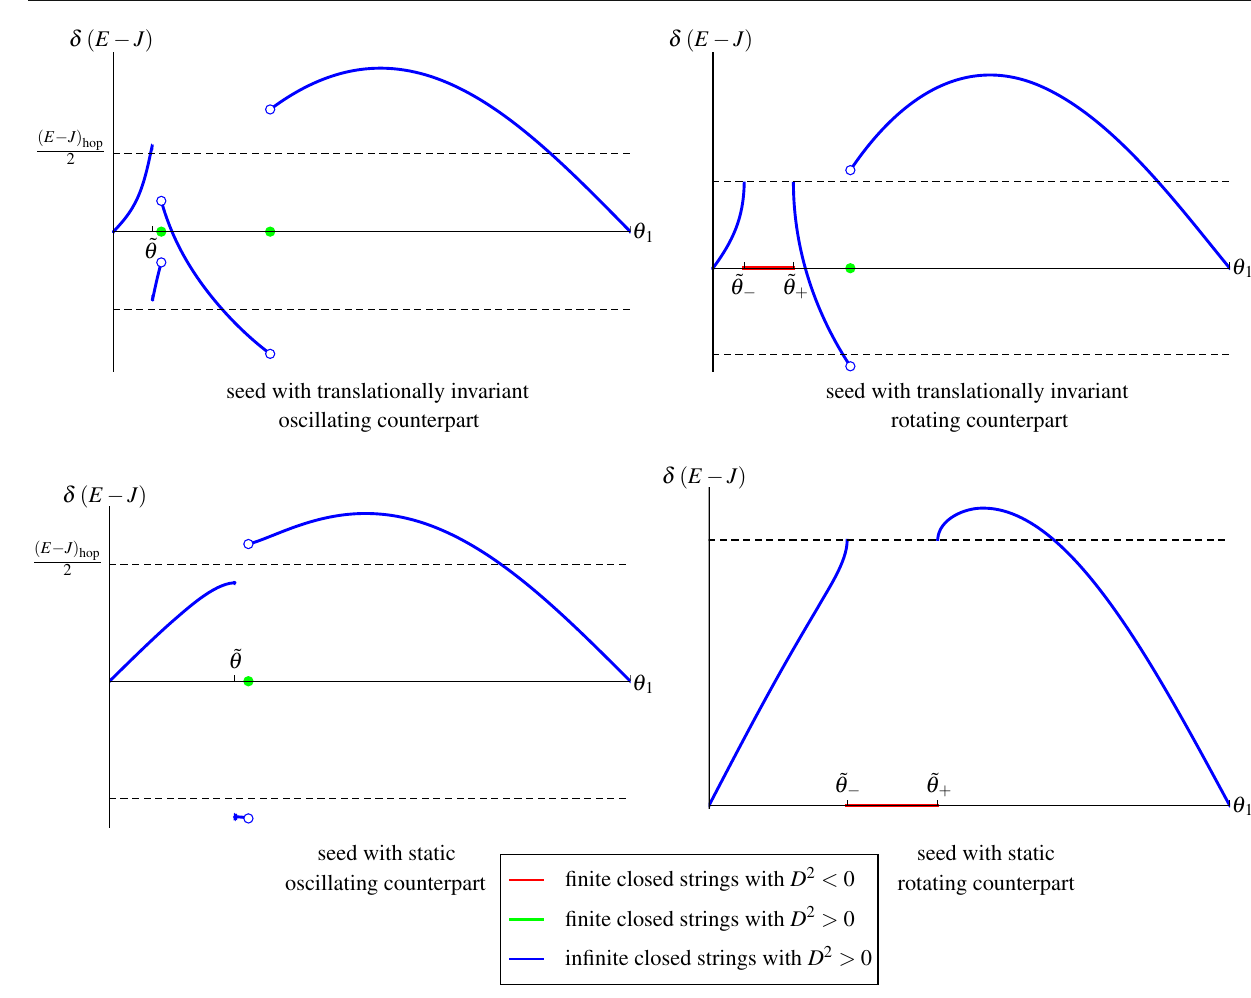
Fig. 26 The ( E − J ) dressed − ( E − J ) seed as function of the angle θ 1 dressed strings whose seed solutions have oscillating sine- θ 1 , which determines the position of the poles of the